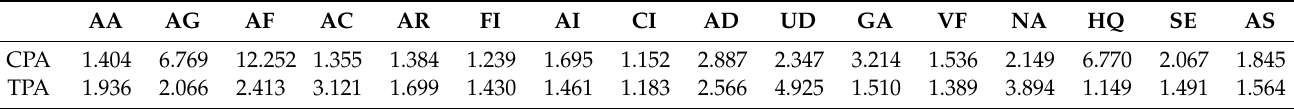
Table 3. Diagnostic results of multicollinearity for LUT factors.